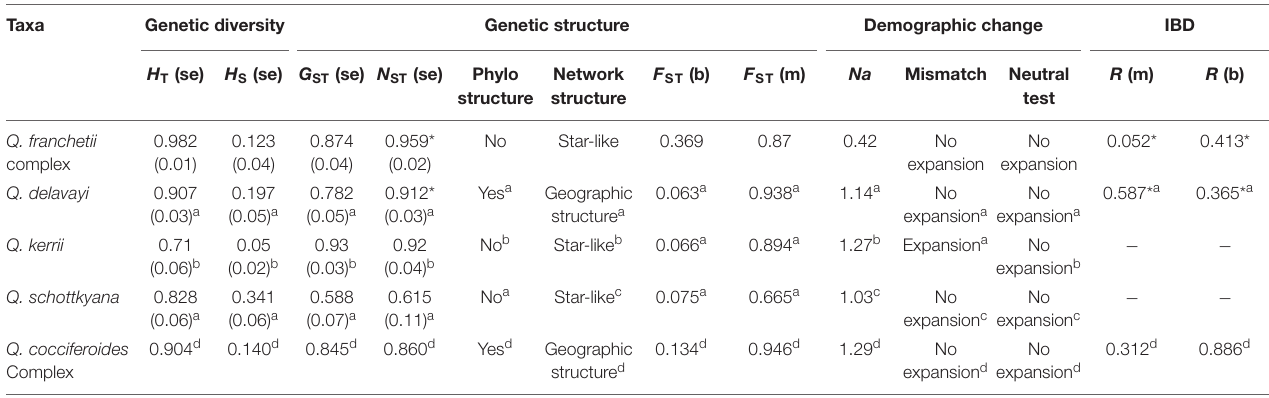
TABLE 4 | Comparisons of the genetic diversity, genetic structure, and demographic dynamics of Quercus franchetii complex with Q. schottkyana , Q. kerrii , Q. schottkyana, and Q. cocciferoides complex.